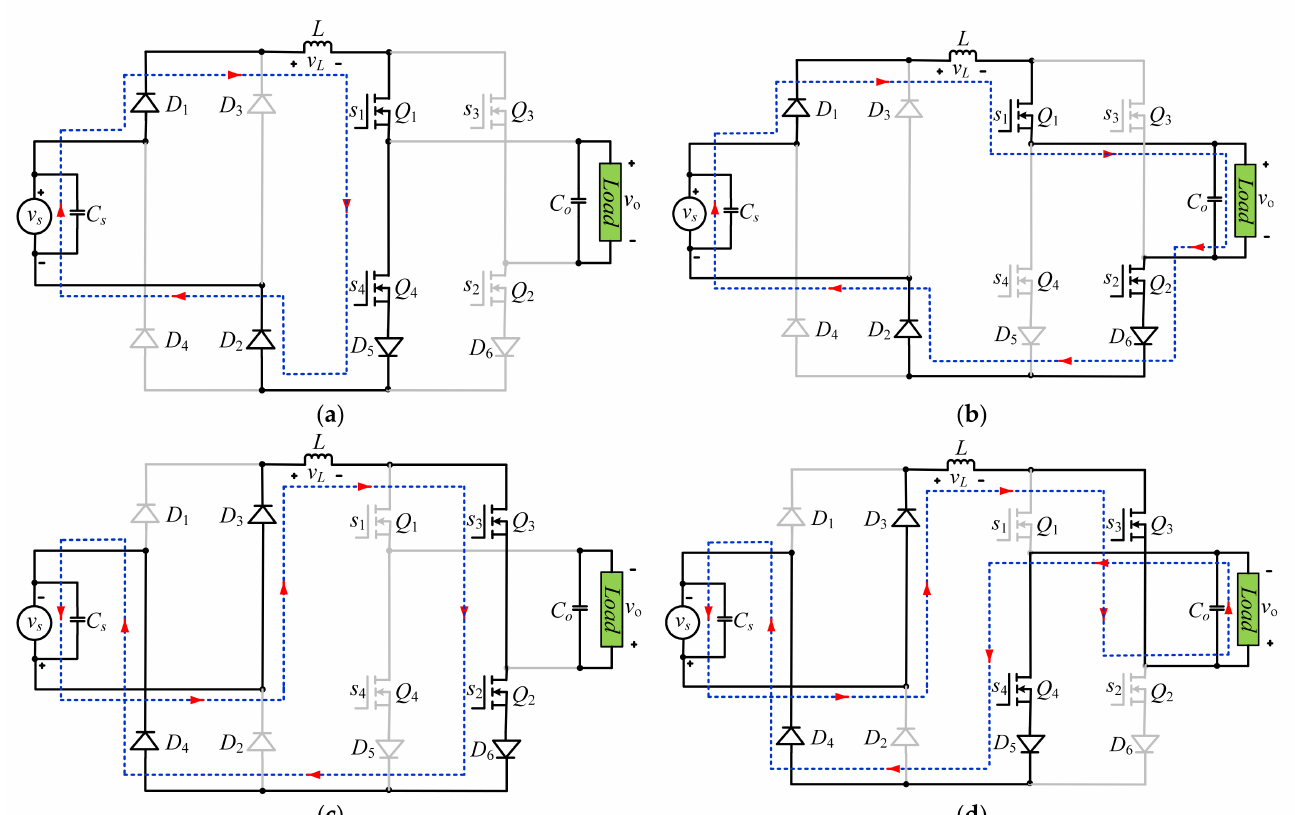
Figure 8. In-phase voltage boost operation during ( a , c ) shoot-through interval of positive and negative input voltage, respectively; ( b , d ) energy transfer interval of positive and negative input voltage,